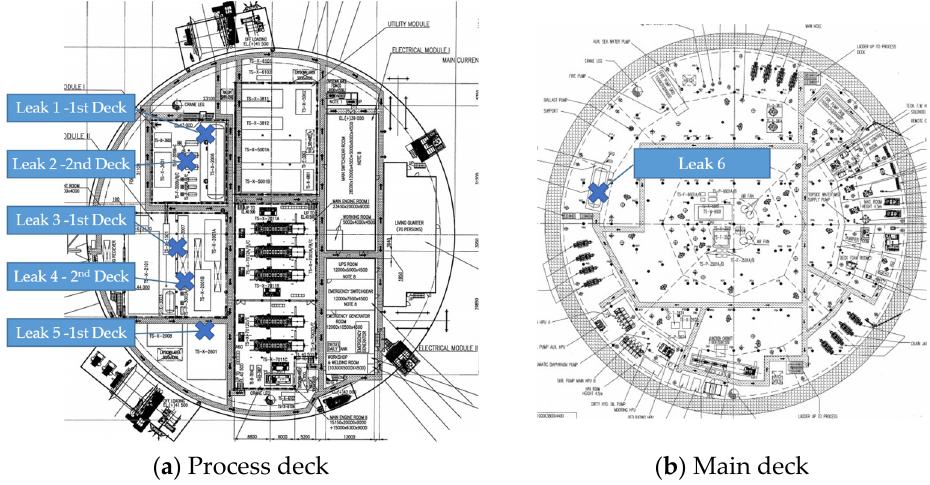
Figure 8. Representative leak locations for LH11-1 FPSO FERA. ( a ) is the process deck; ( b ) is the main deck.